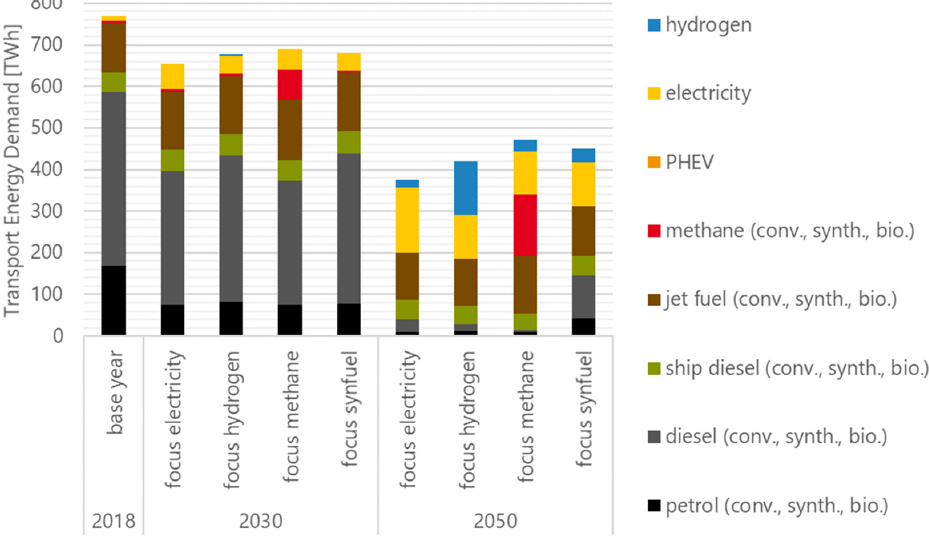
Figure 3. Final energy demand in 2030 and 2050 distinguished by energy carrier in the four scenarios.